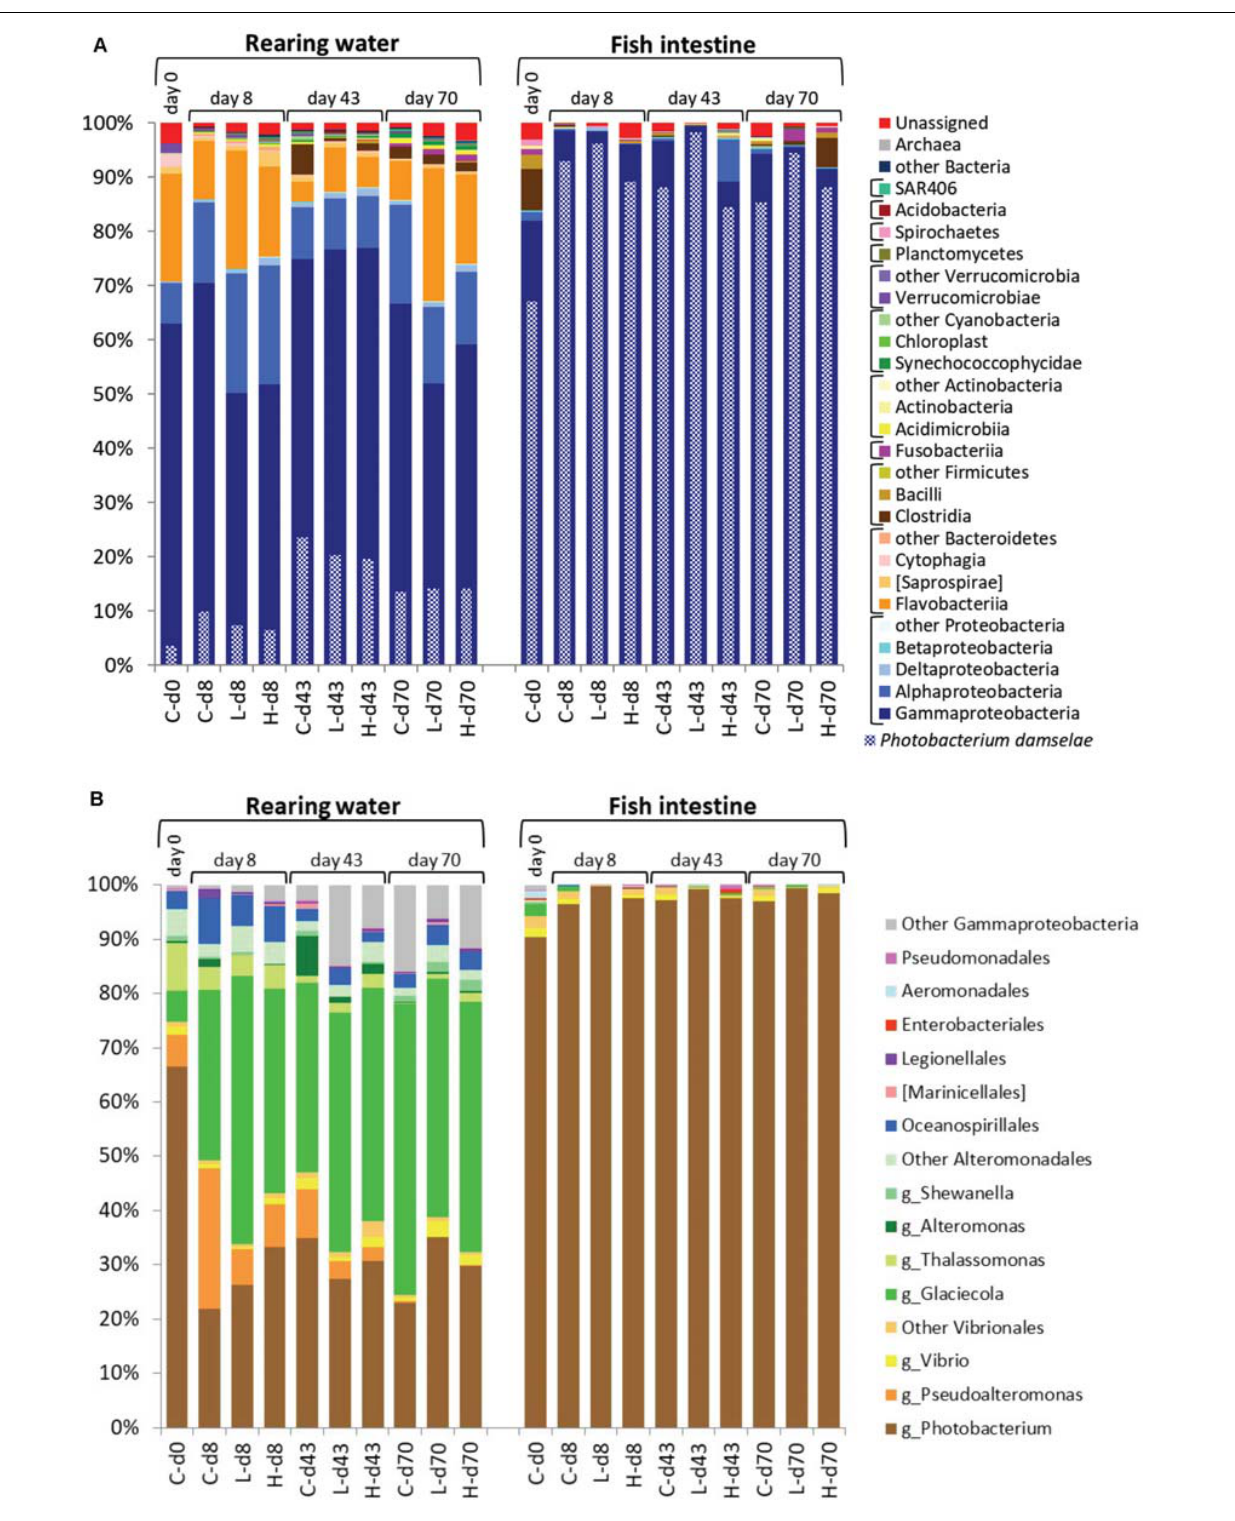
Frontiers in Microbiology |